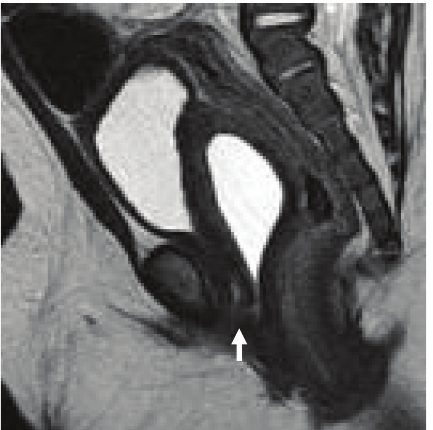
Figure 4: Sagittal T2 TSE MR image revealing the communication between the prostatic utricle cyst and the urethra (white